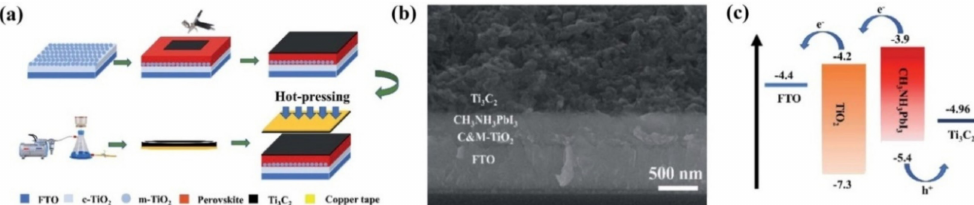
Figure 8. ( a ) Fabrication process of Ti 3 C 2 electrode-based PSC employing hot-pressing technique. ( b ) Cross-sectional SEM image ( c ) Representative energy-level alignment of the PSC. Reprinted with permission from Ref. [94]. Copyright 2019 The Royal Society of